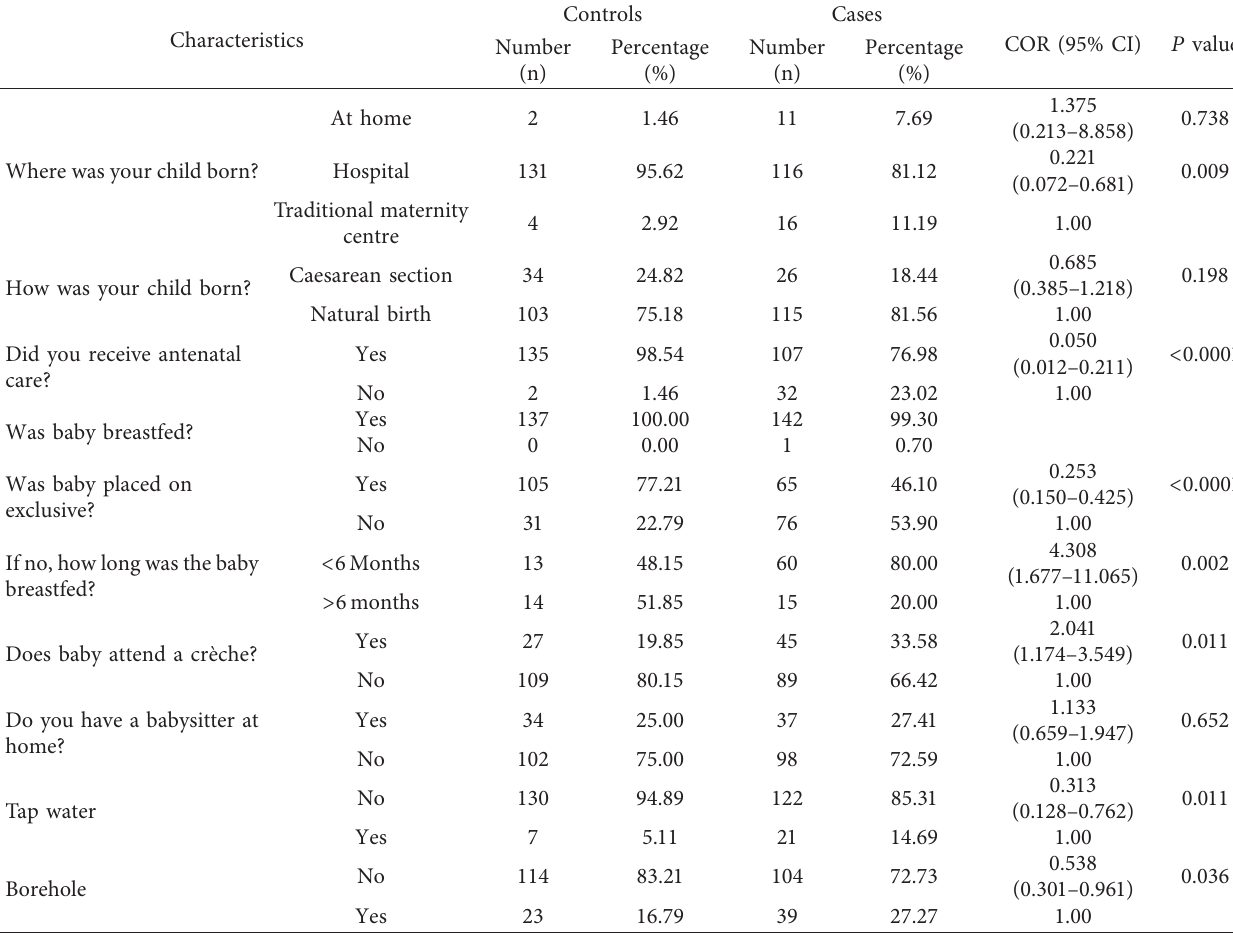
Table 3: The association between medical history and environmental variables and